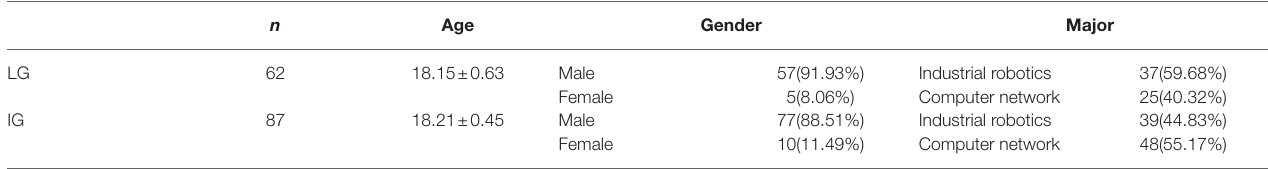
TABLE 1 | Demographic data (age, gender, and major) divided into groups.